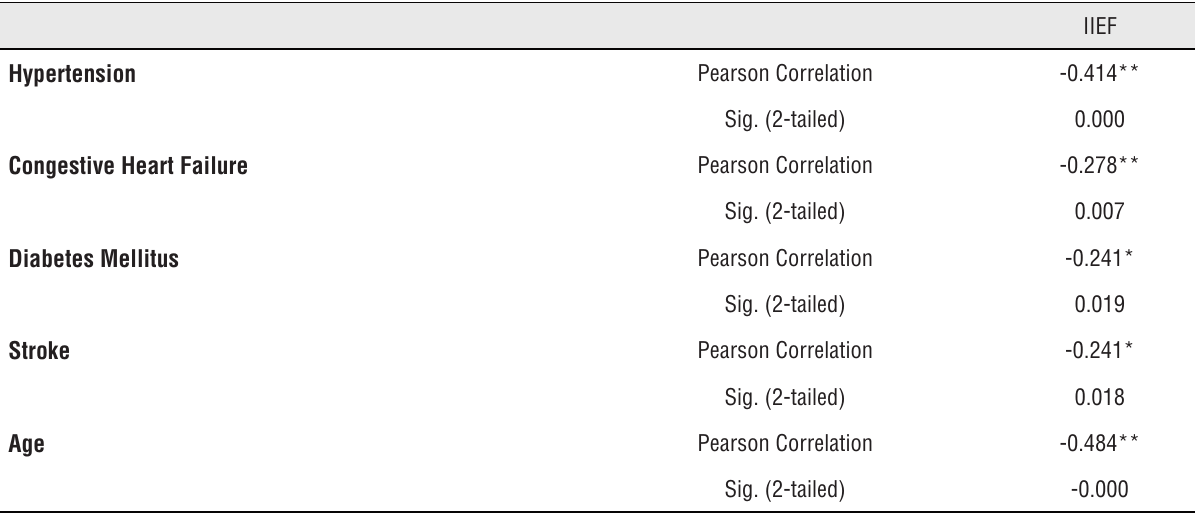
Table 2 - Correlation between IIEF score and clinical